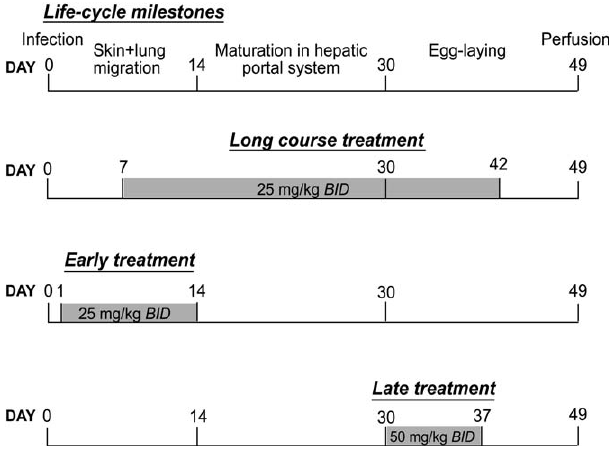
Figure 1. Experimental Design for Assessing the Therapeutic Effect of the Cysteine Protease Inhibitor K11777 on Mice Infected with S. mansoni All mice were infected with 150 S. mansoni cercariae injected subcutaneously. K11777 was administered intraperitoneally in 100 l l of water at the dosages and timings indicated. Control mice received water alone. All mice were perfused at 49 days p.i., and worm and egg burdens and organ pathology were assessed.